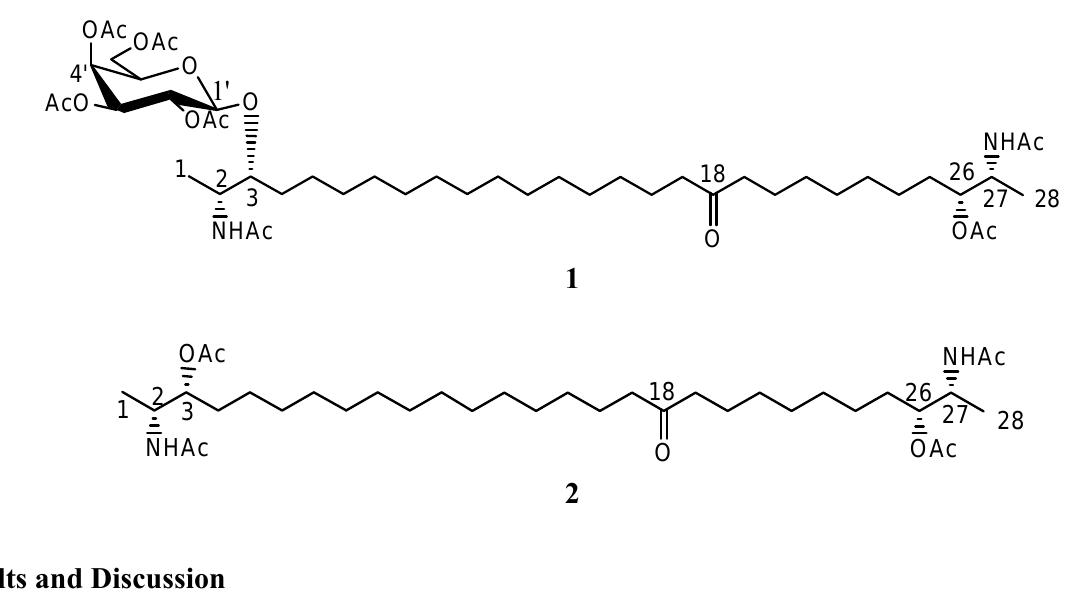
Figure 1. Structures of acetylated compounds 1 and 2